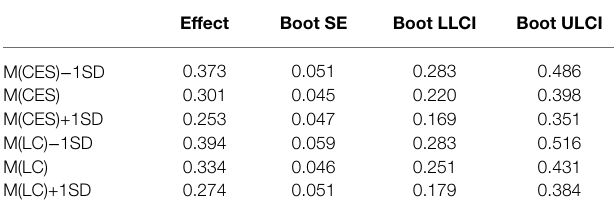
TABLE 7 | Results for conditional indirect effect analysis.